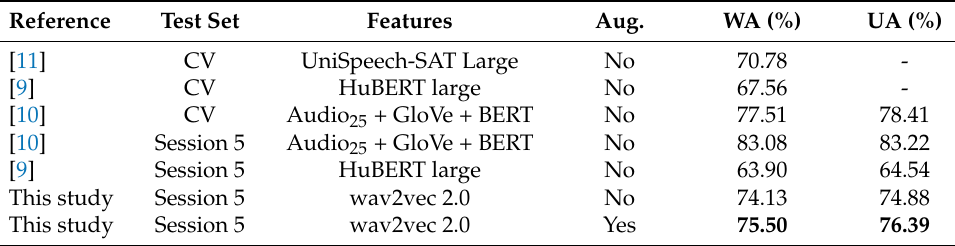
Table 7. Comparison of IEMOCAP performances. The highest scores in this study are in bold.